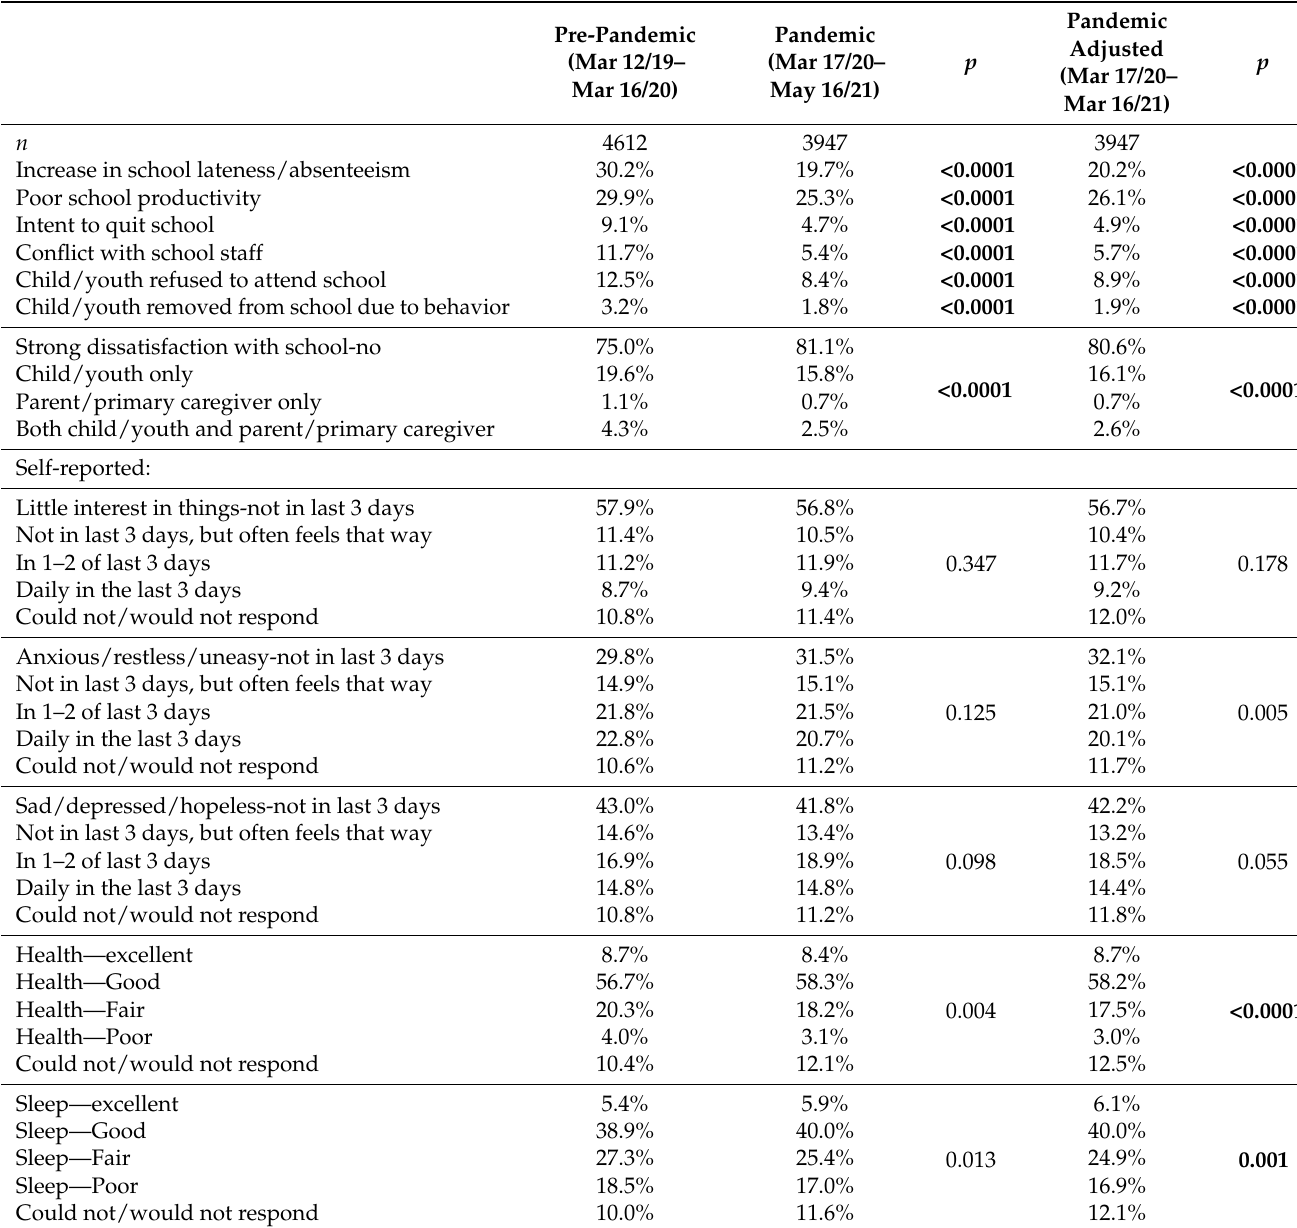
Table 3. Selected school and self-reported items, by year, with and without